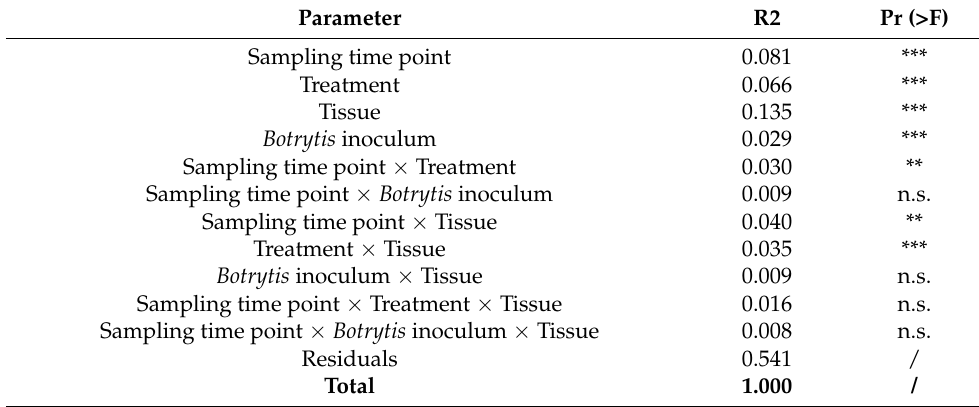
Figure 2. Box and whisker plot for the values of the Shannon index (left) and number of observed features (right), with samples grouped according to tissue (A), time point (B), and treatment (C). Upper and lower box bounds are associated with the 75 th and 25 th percentile of the distribution, while upper and lower whisker are associated with the 91 st and 9 th percentile of the distribution, respectively. For each metric, different letters indicate statistically significant differences between groups ( p < 0.05). Table 7. PERMANOVA analysis results for fungi. The R2 value indicates the total variance fraction explained by the parameter or combination of parameters, while Pr (>F) is the FDR-adjusted p -value using the Benjamini-Hochberg method. For significance levels, ** = p < 0.01, *** = p < 0.001, and n.s. = not